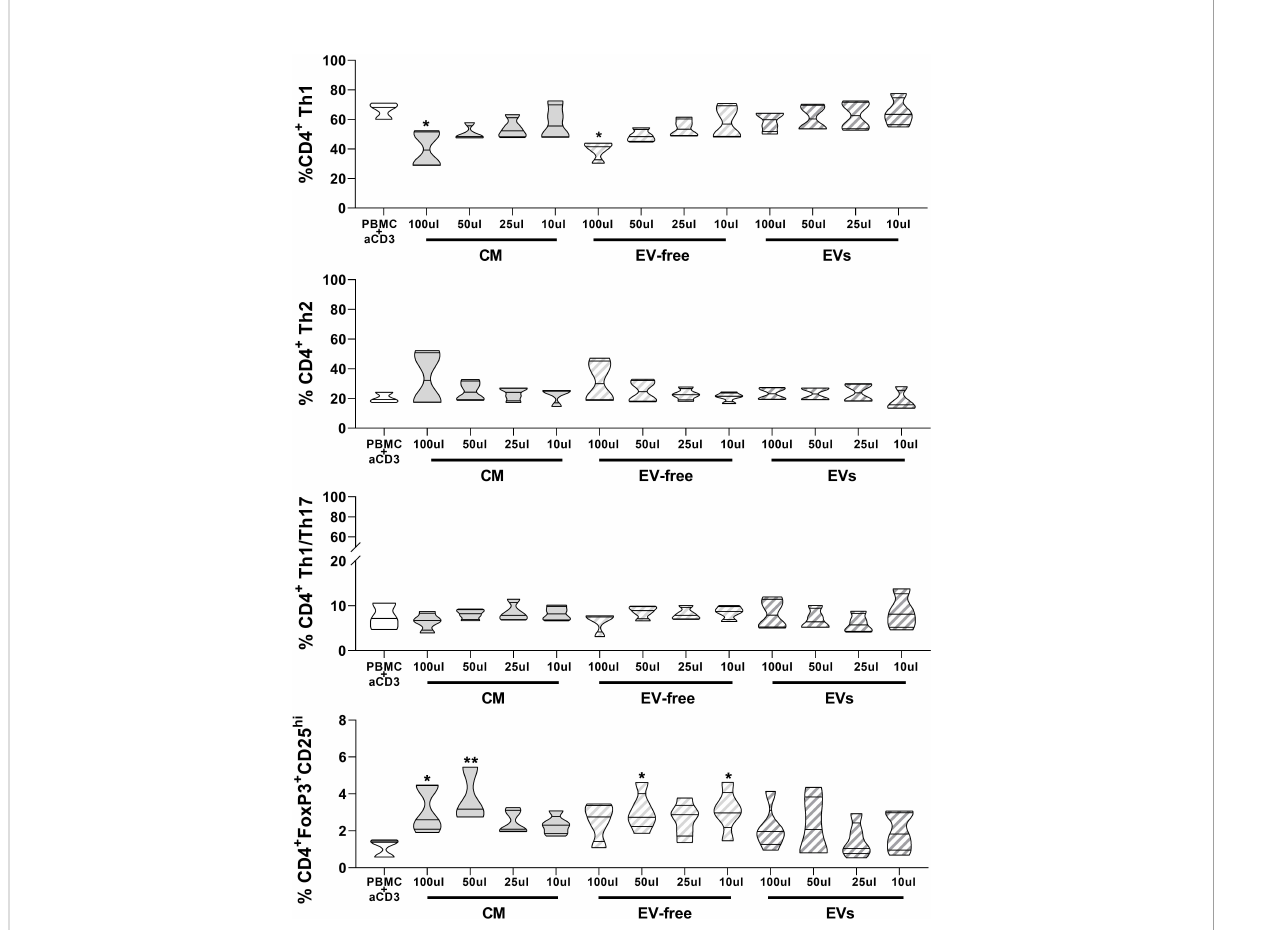
FIGURE 3 Effects of hAMSC-CM and its fractions (EV-free and EVs) on the differentiation of T lymphocytes toward Th1, Th2, Th1/Th17, and Treg subtypes. Allogeneic PBMCs were incubated with anti-CD3 mAb in the presence of 100, 50, 25, or 10 µl of hAMSC-CM in toto or with the same volumes of the EV-free or EV fractions. Samples were collected after 5 days of culture. Results are expressed as percentage of the different Th subsets investigated: Th1 (CD183 + CD196 − ), Th2 (CD183 - CD196 - CD194 + ), Th1/Th17 (CD183 + CD196 + ), and Treg (CD4 + CD25 hi FoxP3 + ). Results are displayed as violin plots showing median (thick line) and 25th and 75th quartiles (* p <0.05, ** p <0.01, N ≥ 3 individual